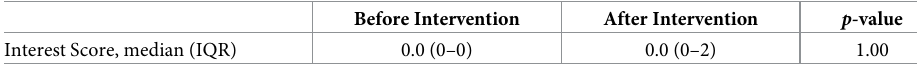
Table 3. Interest in methadone before and after brief intervention (n =